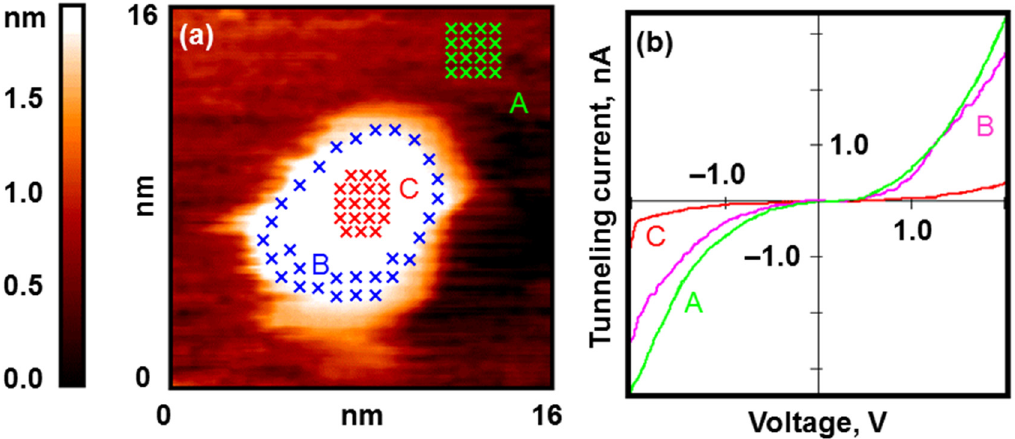
Figure 6. Nickel nanoparticles after exposure to O 2 (200 L). Results of the STM/STS measurement: ( a ) topography image of the HOPG surface with deposited nickel nanoparticle with points of spectroscopy measurements marked with crosses; ( b ) VAC curves of the tunneling currents averaged over the set of points on the surface of the HOPG (green curve A), central (red curve C) and peripheral (pink curve B) areas of the nanoparticle marked in ( a ).